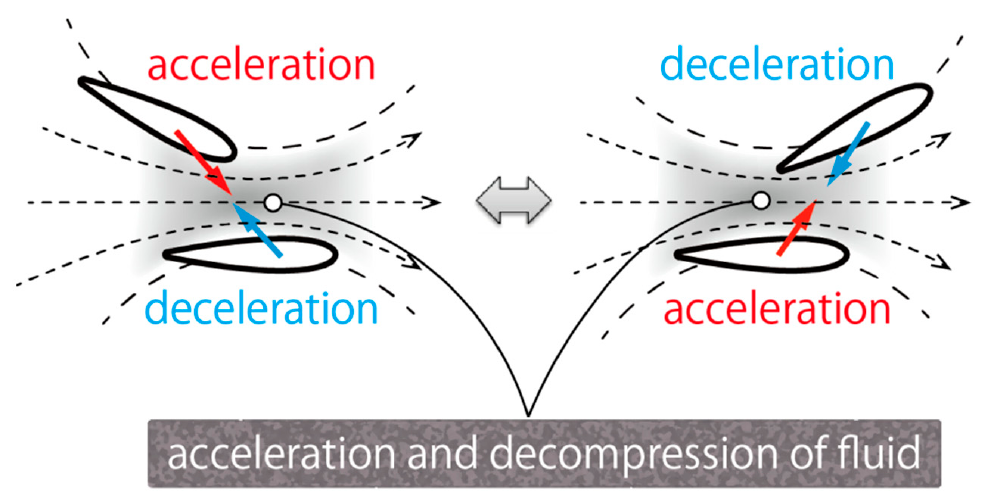
Figure 21. Expected principle of phase synchronization in closely spaced wind turbines.